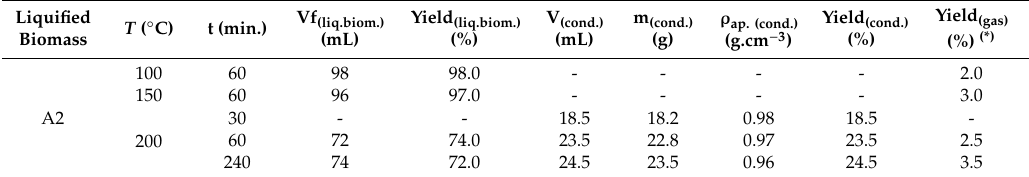
Table 4. Experimental results obtained with complementary experiences in the syngas / methane reactor. Liquified